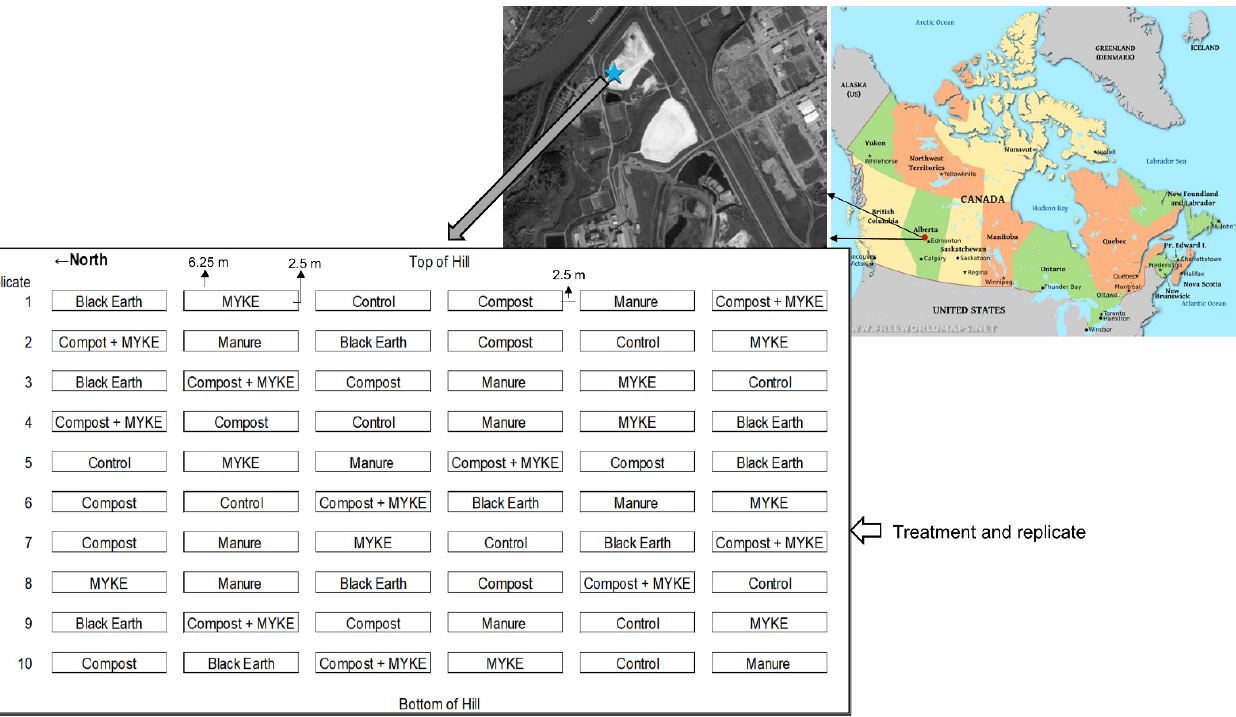
Figure 1. Location research sites with experimental design. Star indicates research site.